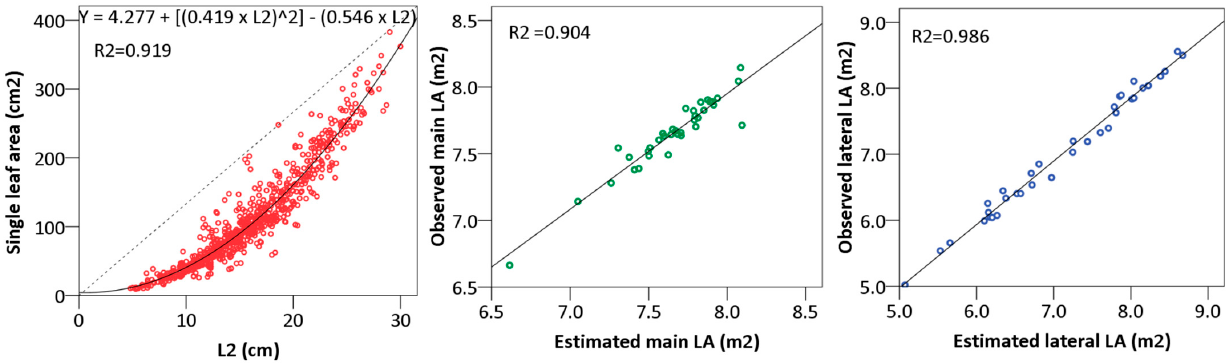
Figure 1. Correlations between the observed and estimated values of the single LA (red dots), main LA (green dots), and lateral (blue dots) LA models for Carignano.